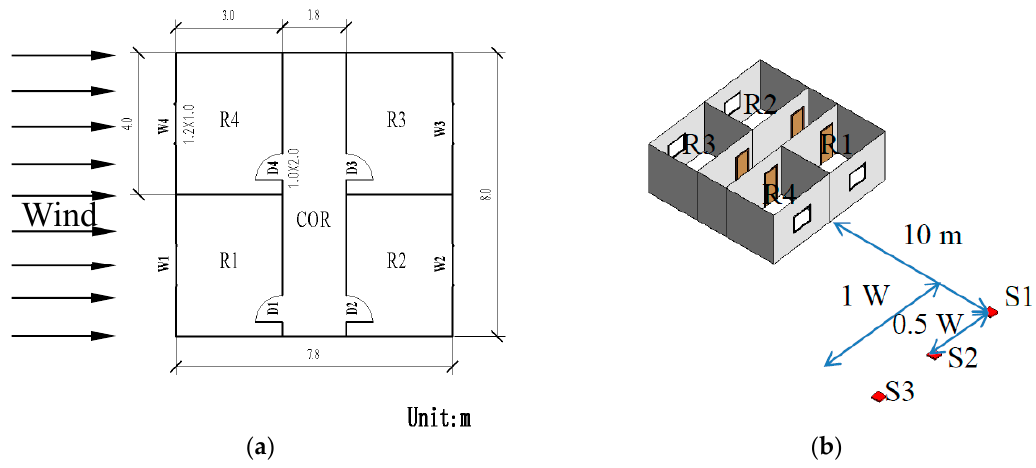
Figure 4. ( a ) Schematic diagram; ( b ) Plan view of the building model.